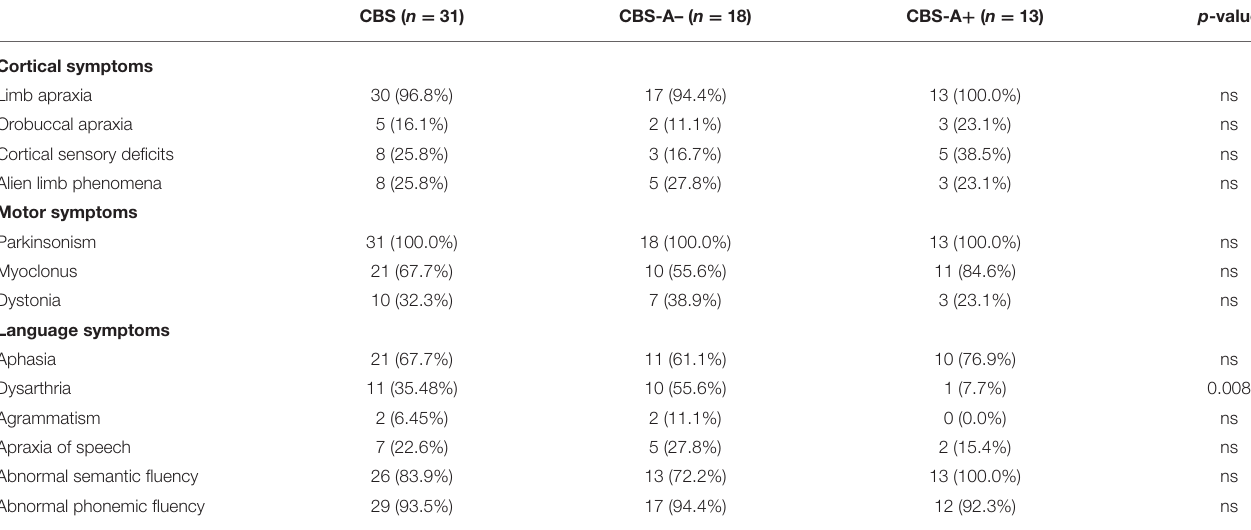
TABLE 2 | Clinical symptoms and signs of patients with CBS and comparison by amyloid-PET